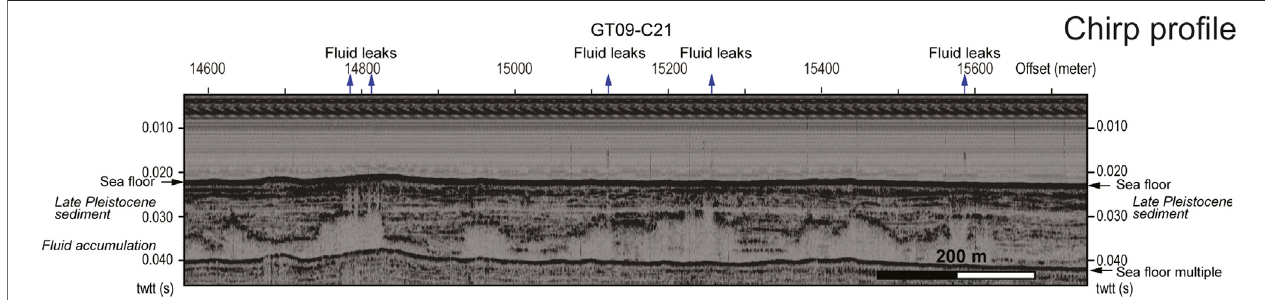
FIGURE 3 | The chirp pro fi le GT09-C21, located along the initial part of the seismic pro fi le (see the small rectangle in Figure 2B ), imaging fl uid accumulation in the Late Pleistocene sediment, evidenced by the blanking effect and by the high amplitude re fl ectors on the top. Where the fl uid migration rises very close to the sea fl oor, fl uid plumes occur in the water column (blue arrows in the